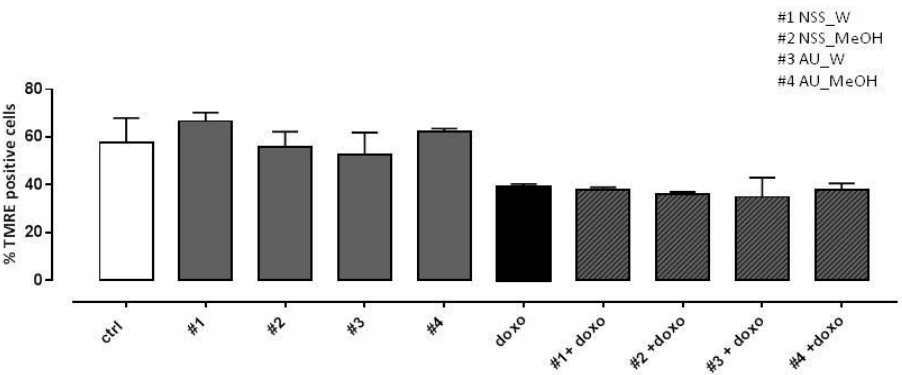
Figure 5. E ff ect of NSS and AU extracts on doxo-induced mitochondrial membrane depolarization. NSS and AU extracts (50 µ g / mL) were administered alone for 24 h or 4 h before doxo (1 µ M). The mitochondrial membrane potential was evaluated by flow cytometry analysis with Tetramethylrhodamine ethyl ester (TMRE), a cell-permeant, positively-charged, red-orange dye which penetrates and accumulates in the mitochondria in inverse proportion to the membrane potential. The low value of percentage of TMRE + cells means that the TMRE dye was not trapped in the mitochondrial membrane due to its depolarization. Data were expressed as mean ± SD of fluorescence intensity of at least three independent experiments (N = 6).